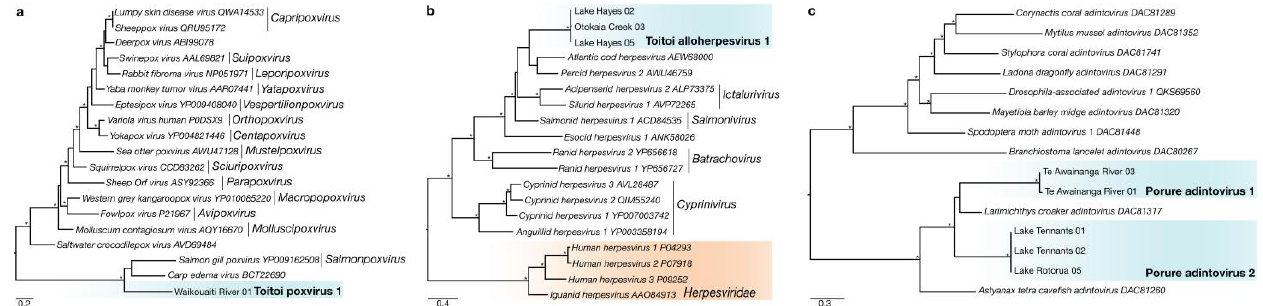
Figure 3. ( a ) Maximum-likelihood phylogenetic tree of the Rpo18 subunit of the DNA-dependant RNA polymerase from representative viruses across the Poxviridae . ( b ) Maximum-likelihood phylogenetic tree of the DNA-dependant DNA polymerase from representative virus from the Alloherpesviridae with the Herpesviridae (indicated in orange) as an outgroup. ( c ) Maximum-likelihood phylogenetic tree of DNA polymerase beta protein homologues from representative viruses across the Adintoviridae . Lineages corresponding to novel fish viruses described in this study highlighted in blue. Asterisks indicated phylogenetic lineages with significant bootstrap values (>70). Branches are scaled to the number of amino acid substitutions per site. Amino acid length of novel DdDp proteins identified in this study used for alignment can be found in Table S1.